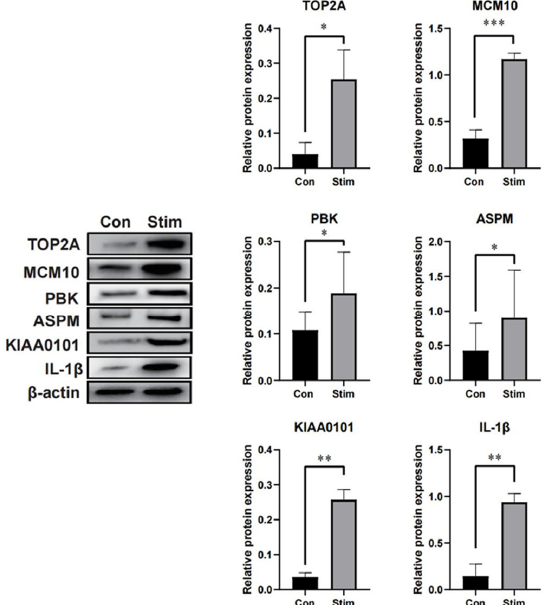
Figure 8. HaCaT cells were treated with recombinant human TNF-α for 24 h. The expression levels of TOP2A, MCM10, PBK, ASPM, KIAA0101 and IL-1β were detected by western blot. The data are represented as means ± SEM; n ≥ 3 in all experiments. * p < 0.05, ** p < 0.01, *** p < 0.001.